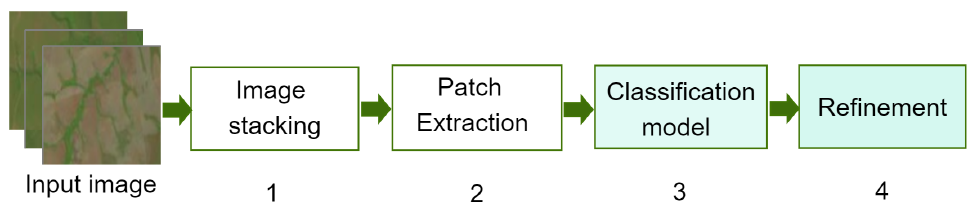
Figure 1. The proposed methodology’s high-level scheme: the benefit of using an enhanced 2D-CNN as a classification model alongside with a post-processing stage for map refinement is